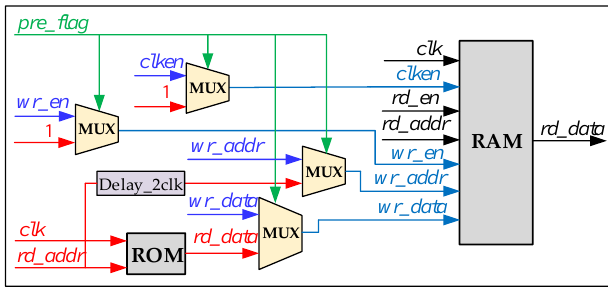
Figure 3. Design of the simulation initial value setting.